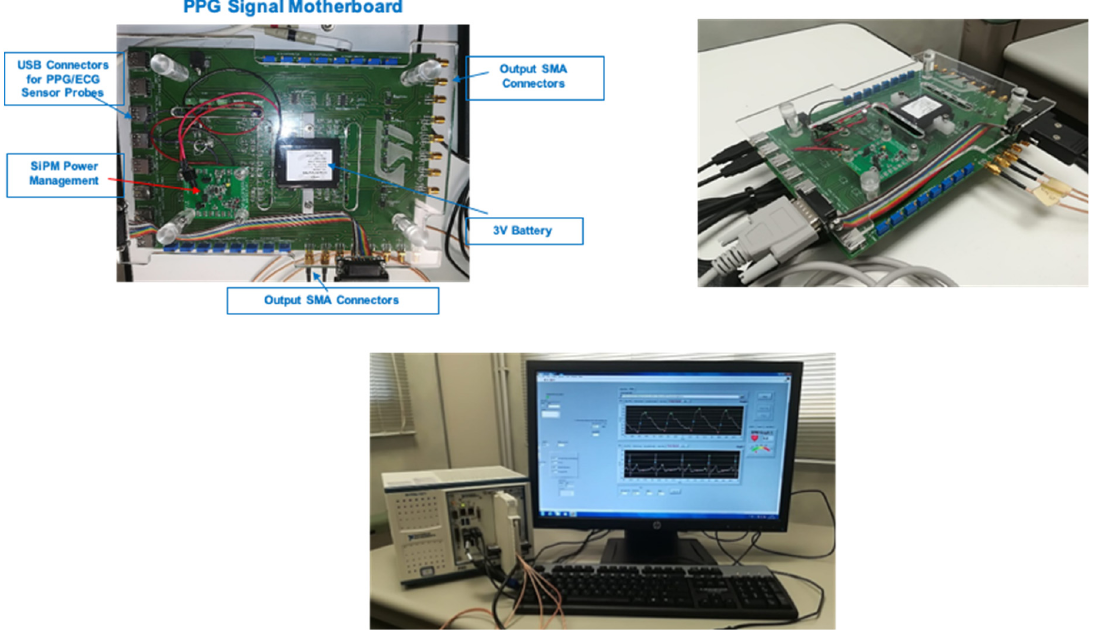
Figure 6. The implemented hardware for sampling PPG signal from the car steering.